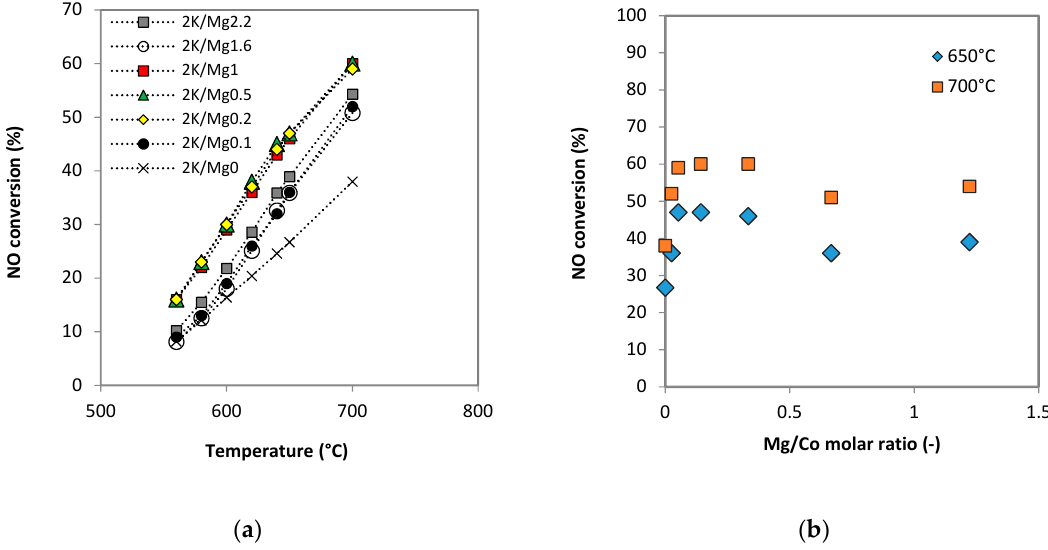
Figure 10. ( a ) Temperature dependence of NO conversion over the 2K / Mg i group of catalysts and ( b ) e ff ect of Mg / Co molar ratio on NO conversion over the 2K / Mg i group of catalysts. Conditions: 1000 ppm NO balanced by N 2 and gas hourly space velocity (GHSV) = 6 L g − 1 h − 1 .